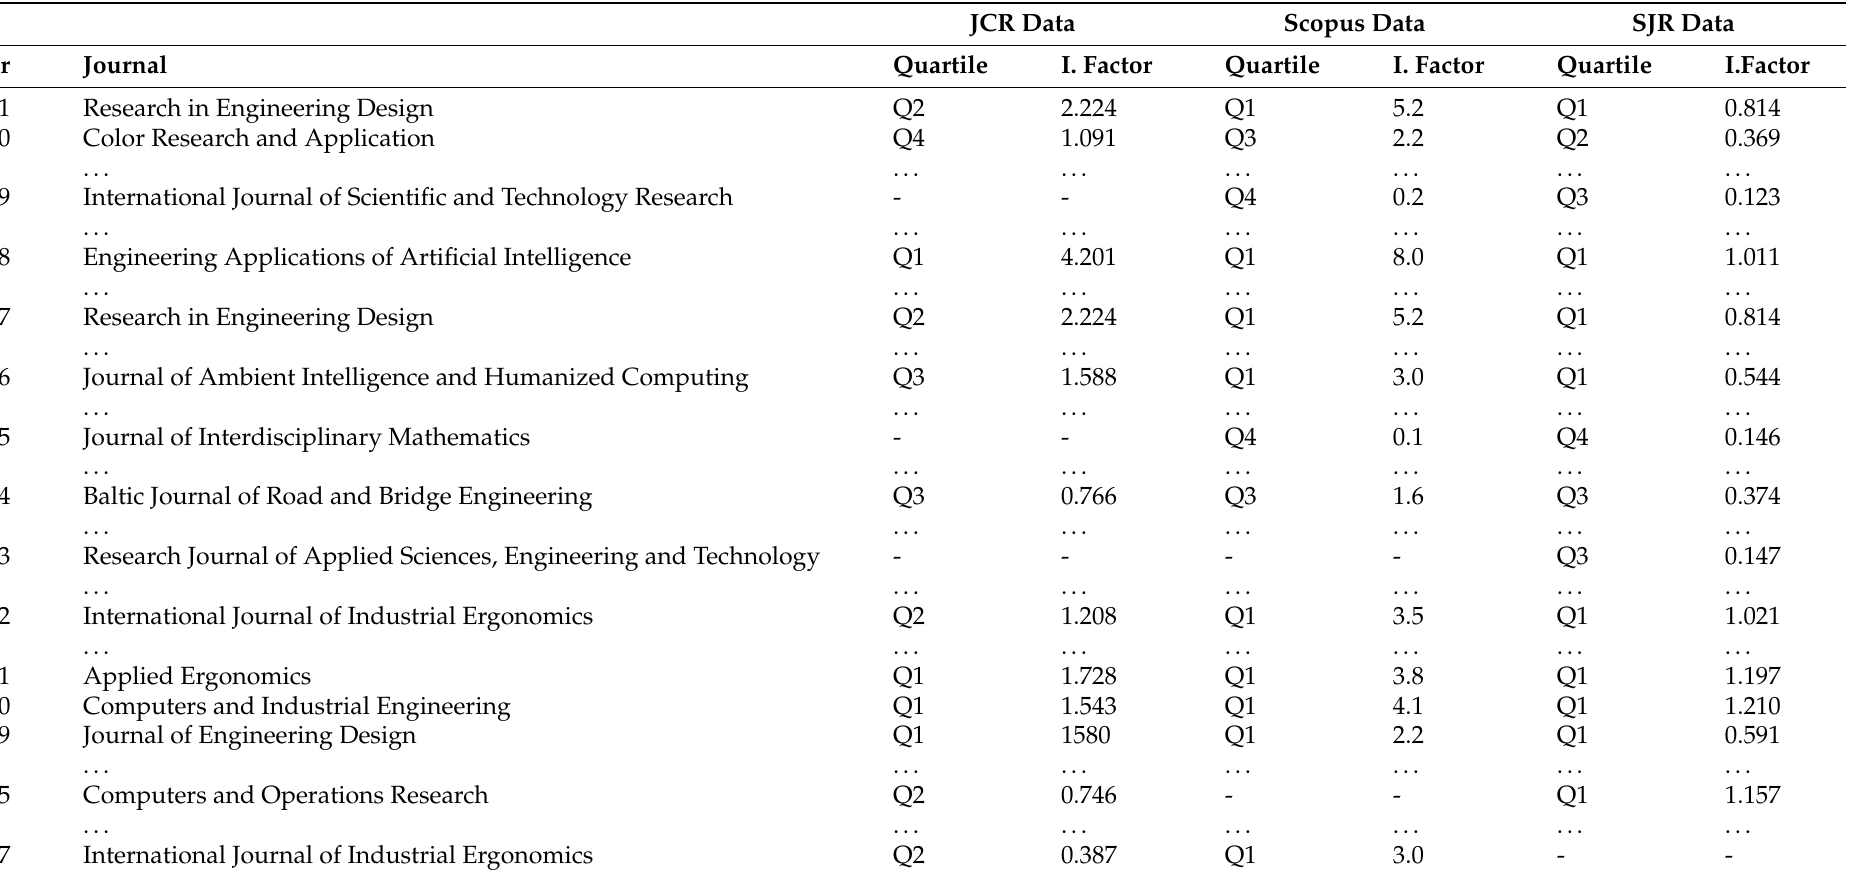
Table 2. Analysed articles and extracted